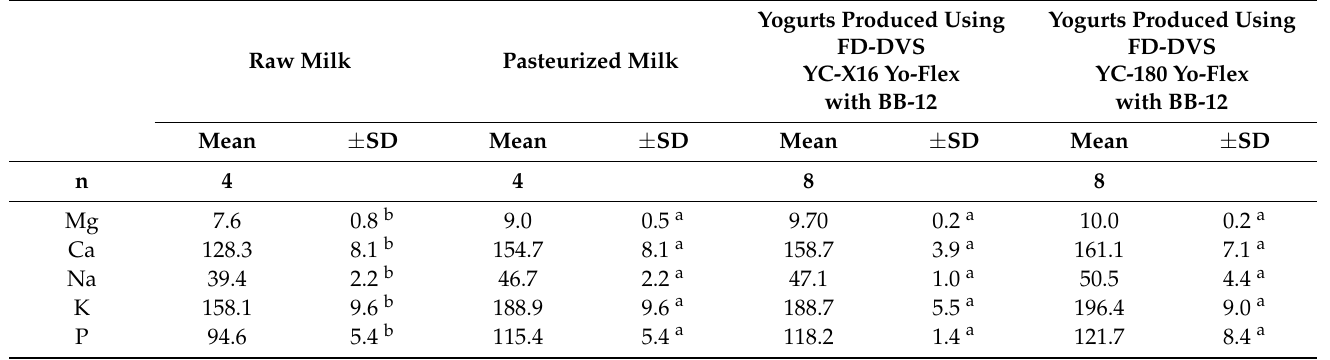
Table 2. Microelements in milk and yogurts produced ( μ g/100 g wet weight). Table 3. Macroelements in milk and yogurts produced (mg/100 g wet